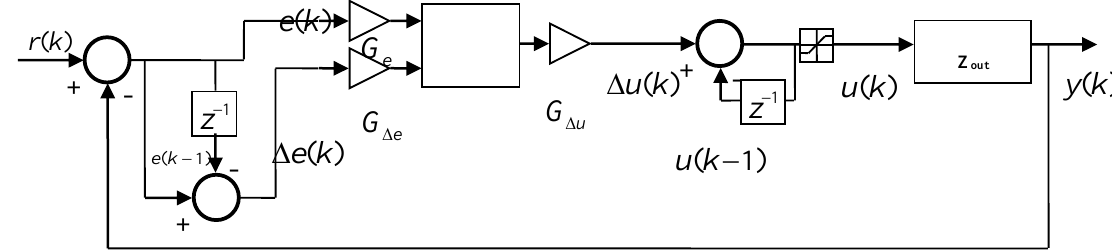
Figure 8. Lighting system controller.